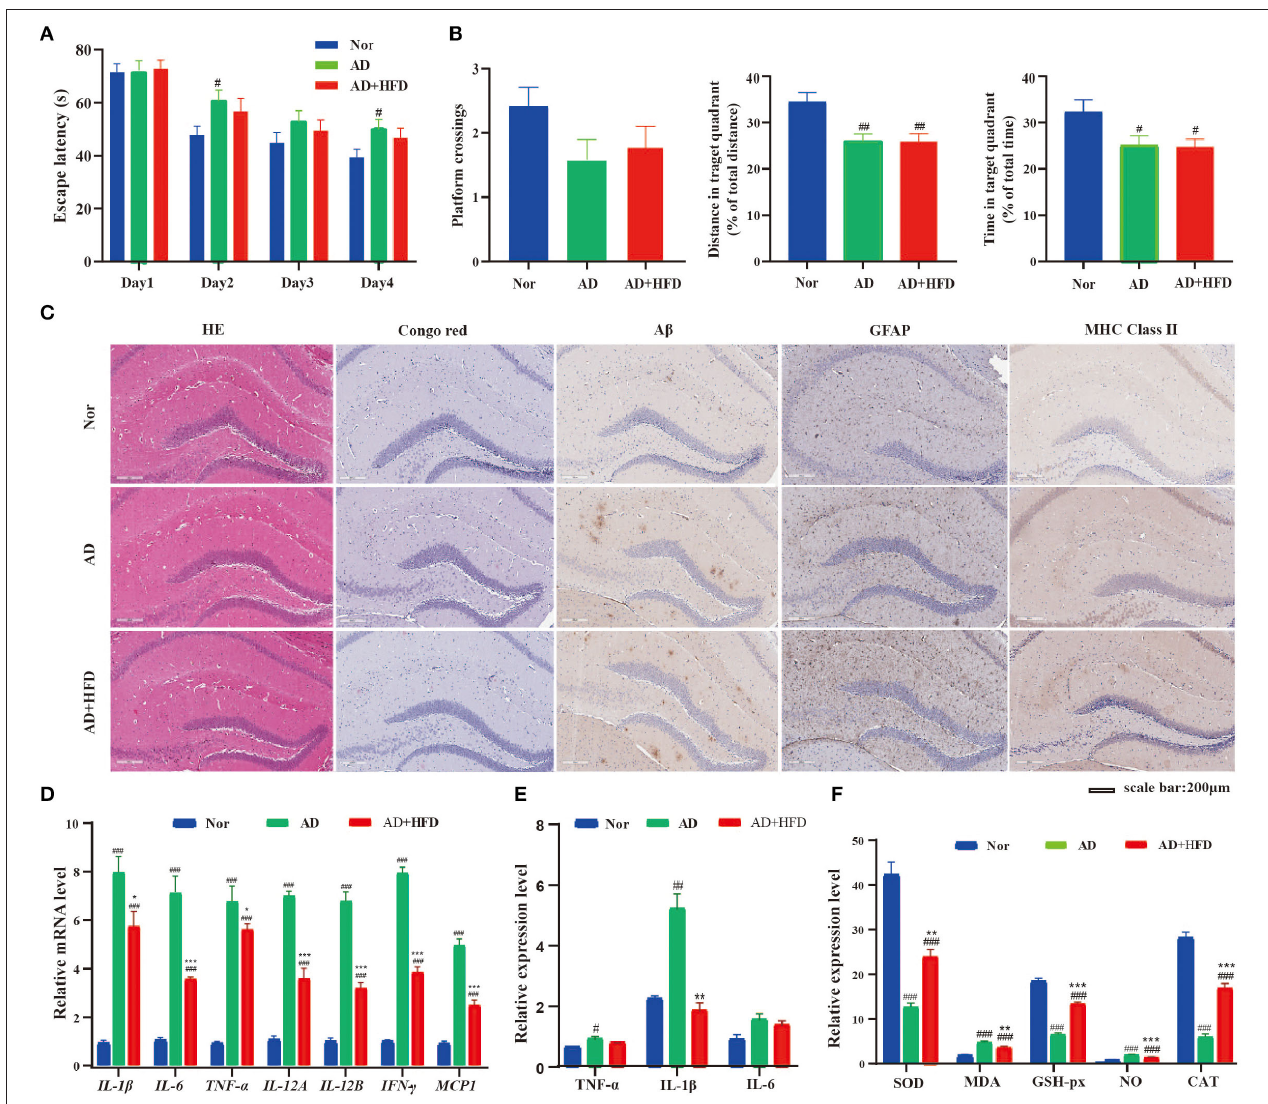
FIGURE 1 | The effect of HFD on APP/PS1 mice cognitive impairment and cerebral pathology. (A) Escape latency during spatial acquisition training, (B) the platform crossing number, distance traveled percentage in the target quadrant and time spent percentage in the target quadrant in the spatial probe test. HFD had no effect on A β level, but HFD could relieve the inflammation in APP/PS1 mice. (C) The HE and Congo red stain in mice brain tissue, A β deposition was determined by Congo red stain and immunohistochemical technique. And the level of GFAP and MHC class II in brain tissue detected by immunohistochemical method. The expression of inflammatory cytokine detected by RT-PCR (D) and Elisa (E) method, respectively. And the indicators of oxidative stress (F) in brain tissue. # p < 0.05, ## p < 0.01, ### p < 0.001 (compared to Nor group); * p < 0.05,** p < 0.01,*** p < 0.001 (compared to AD